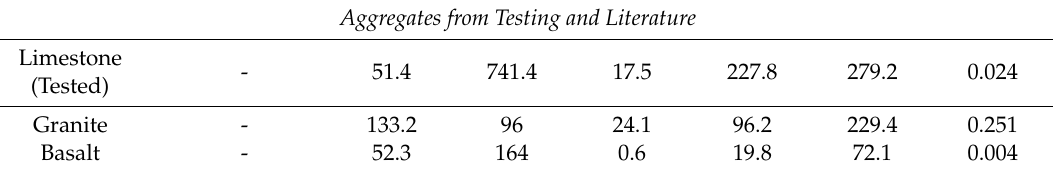
(cid:112) γ + γ − : acid–base